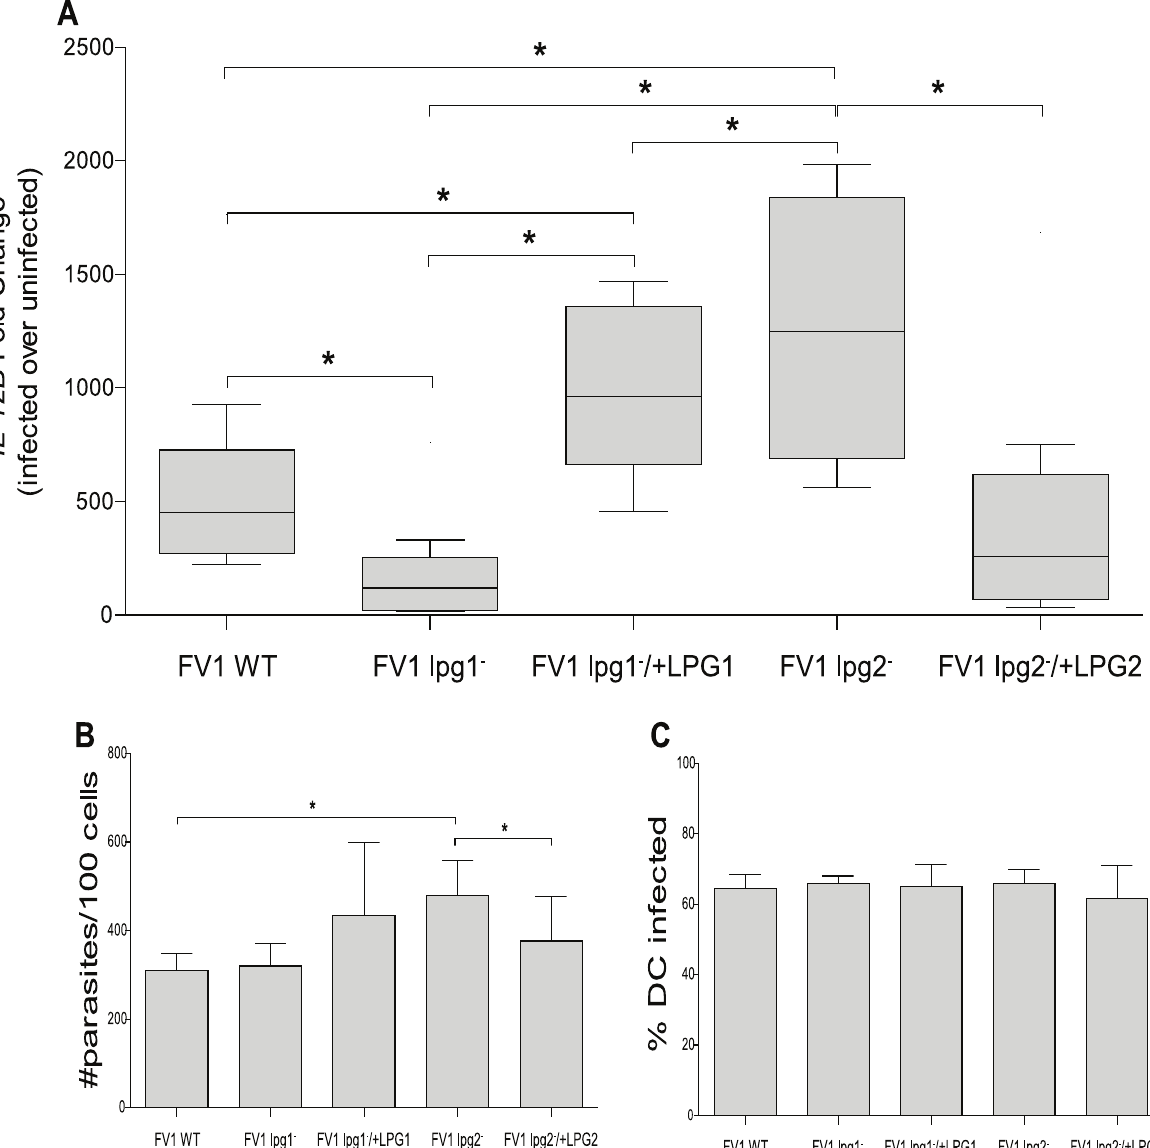
Fig 2. L . major FV1 lpg1 − and FV1 lpg2 − modulate the IL12B response in hDCs. Human DCs (n = 9 donors) were infected with L . major FV1 parasites: L . major FV1 (WT), LPG null mutant (FV1 lpg1 − ), LPG add back (FV1 lpg1 − /+ LPG1 ), PG null mutant (FV1 lpg2 − ), or PG add back (FV1 lpg2 − /+ LPG2 ). ( A ) At 8 hours post infection, IL12B expression was measured by qRT-PCR. Fold changes were calculated using the ΔΔ C T method and are represented as fold change over uninfected samples. Box plots display the median value (line), the interquartile range (box), and Tukey whiskers encompassing data within 1.5 fold of the interquartile range. All values were significantly greater than uninfected. Aliquots from the infected hDC samples were prepared by Diff-Quick staining and visualized by light microscopy. ( B ) The parasite index (#parasites/100 cells) and ( C ) the percentage of infected cells (%DC infected) is displayed. Mean values of individual donors ± SD are presented. * Statistical significance (p <